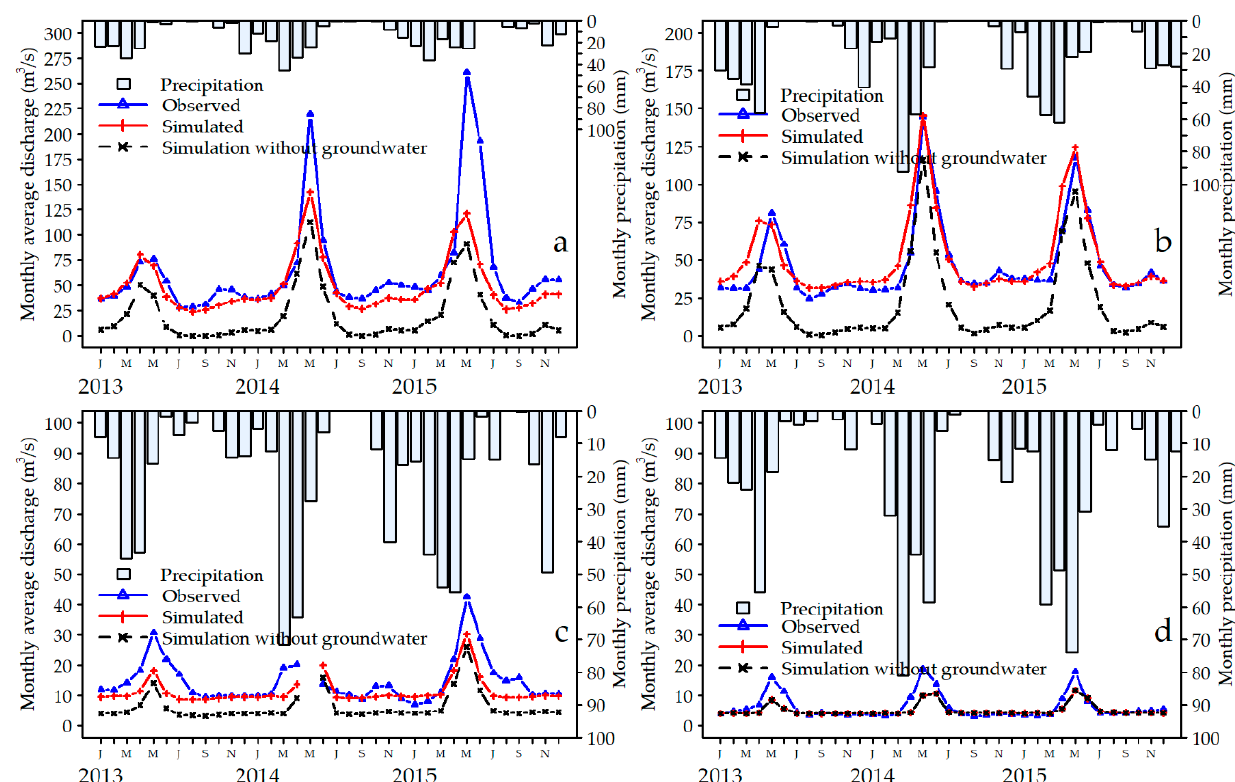
Figure 6. Comparisons between the observed and simulated monthly average discharges with and without groundwater contribution and monthly precipitation in the calibration from 2013 to 2015. ( a ) subbasin 7, ( b ) subbasin 10, ( c ) subbasin 28, and ( d ) subbasin 30.